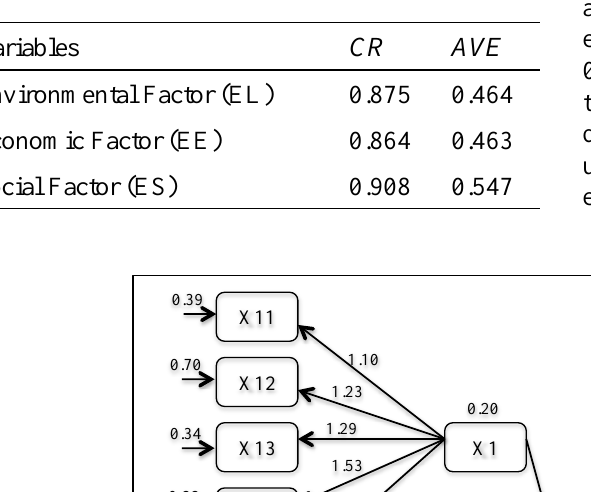
Table 3. Convergent validity of measured variables in terms of Composite Reliability ( CR ) and Average Variance Extracted ( AVE ).